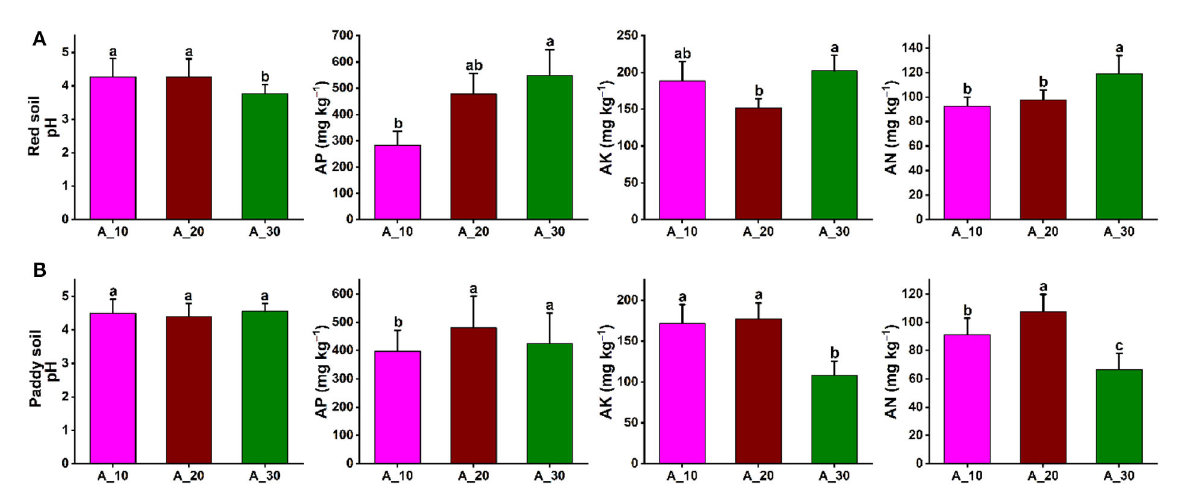
FIGURE1 Variations in soil properties under different tree ages. Variation in soil physicochemical properties (soil pH, AP, AK, and AN) under different groups of tree ages for (A) red soil (B) paddy soil. Here, AP, AK, and AN represent available phosphorous, available potassium, and available nitrogen, respectively. Different lowercase letters indicate the significant differences ( p < 0.05) among different pomelo trees age groups of Age_10 (10 years old), Age_20 (20 years old), and Age_30 (30 years old).